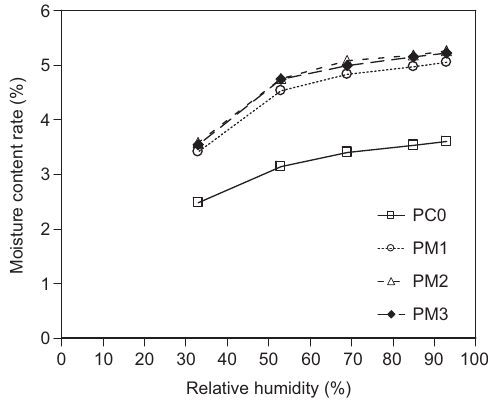
Figure 9 Desorption isotherms of cement mortars within various RHs vs. the montmorillonite